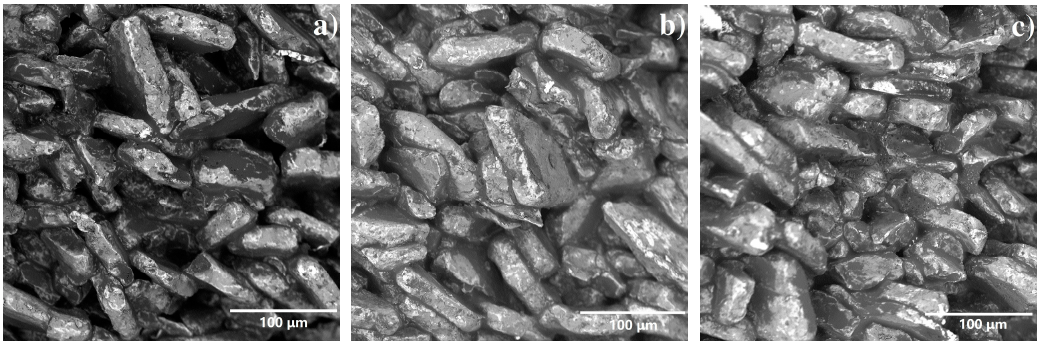
Figure 4. SEM micrographs of AMPCs’ cross-sections under different molding pressures, ( a ) 1.95 GPa, ( b ) 2.15 GPa, and ( c ) 2.35 GPa.